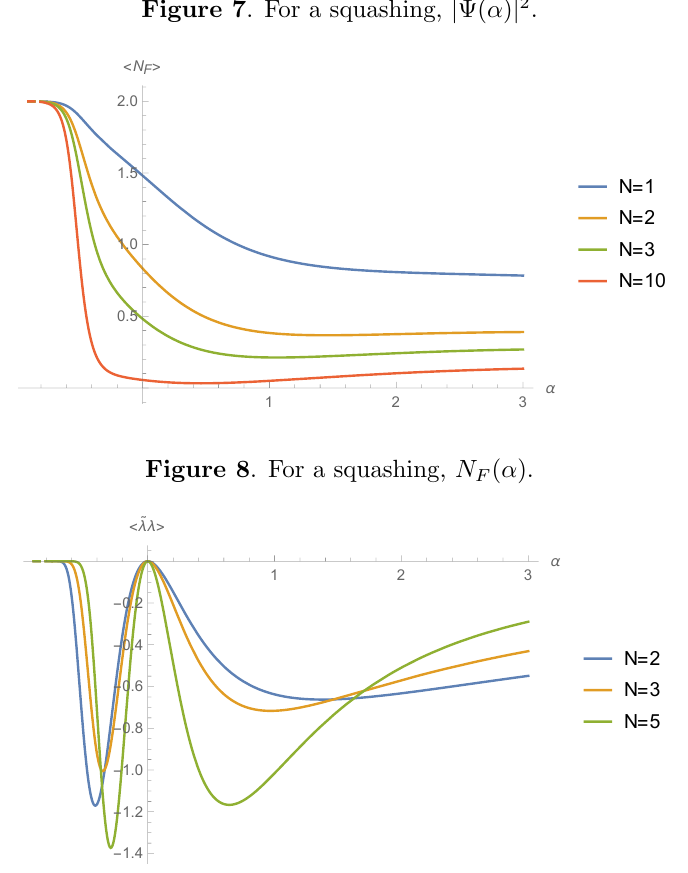
Figure 7 . For a squashing, j (cid:9)( (cid:11) ) j 2 .